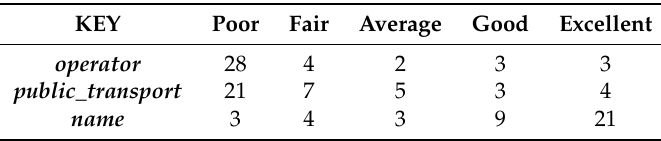
Table 11. Summary of compliance of all cities with suggested tag key combinations for the target tag highway=bus-stop